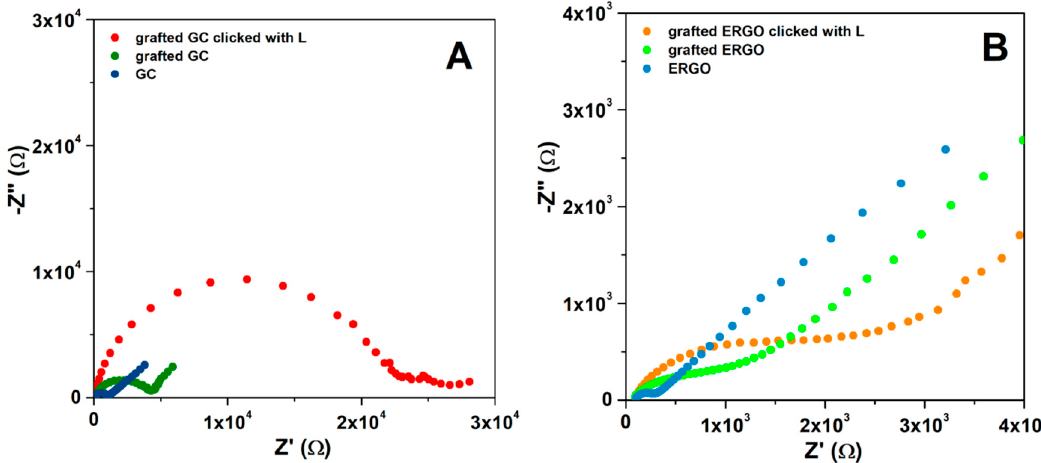
Figure 4. Electrochemical impedance spectra (Nyquist plots) recorded in 5 mM Fe(CN) 63 − / 4 − , 0.1 M KCl solution, at ( A ) GC and ( B ) GC-ERGO electrodes, at different modification steps.